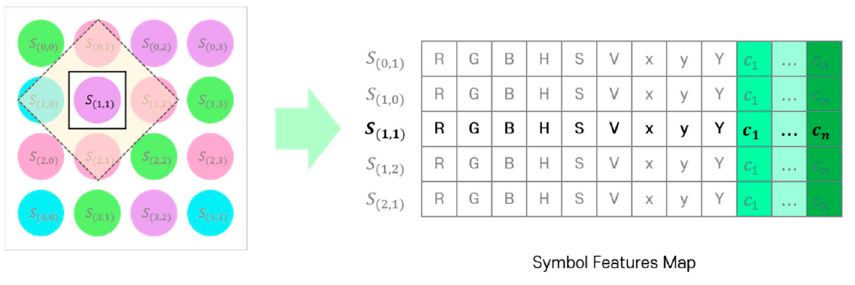
Figure 6. Symbol feature map generated using the adjacent symbol area.